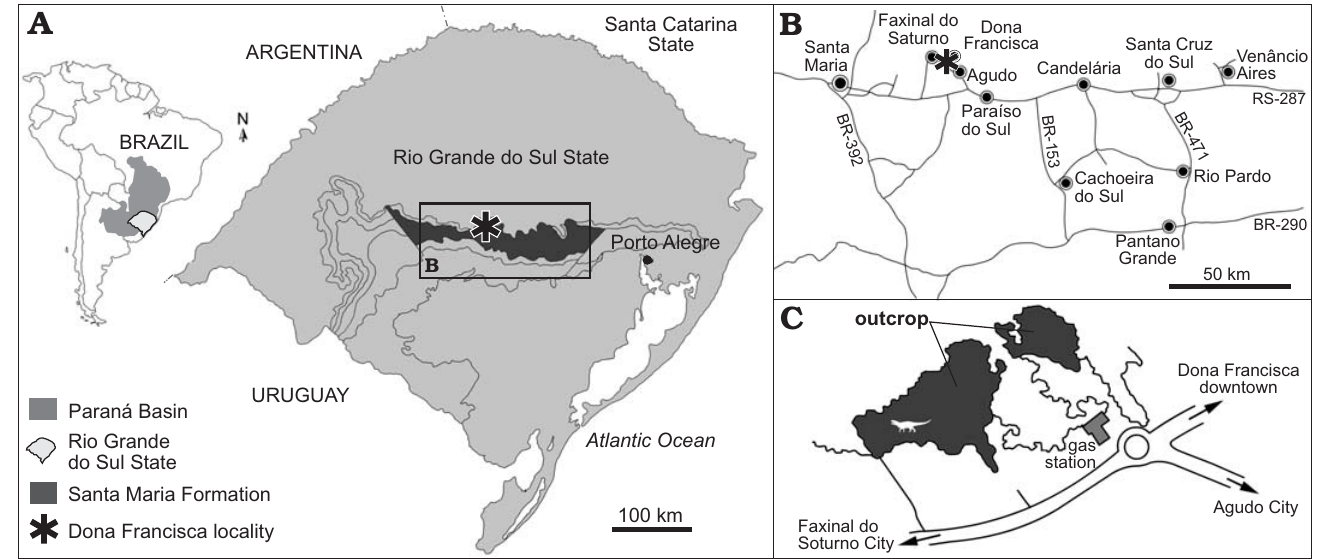
Fig. 2. Map showing location of the studied area, where the Prestosuchus chiniquensis Huene, 1938 (UFRGS-PV-0629-T) was collected, within Rio Grande do Sul State, Brazil ( A ) and municipality of Dona Francisca ( B , C ). Coordinates of the outcrop “Posto de Gasolina” UTM (22)